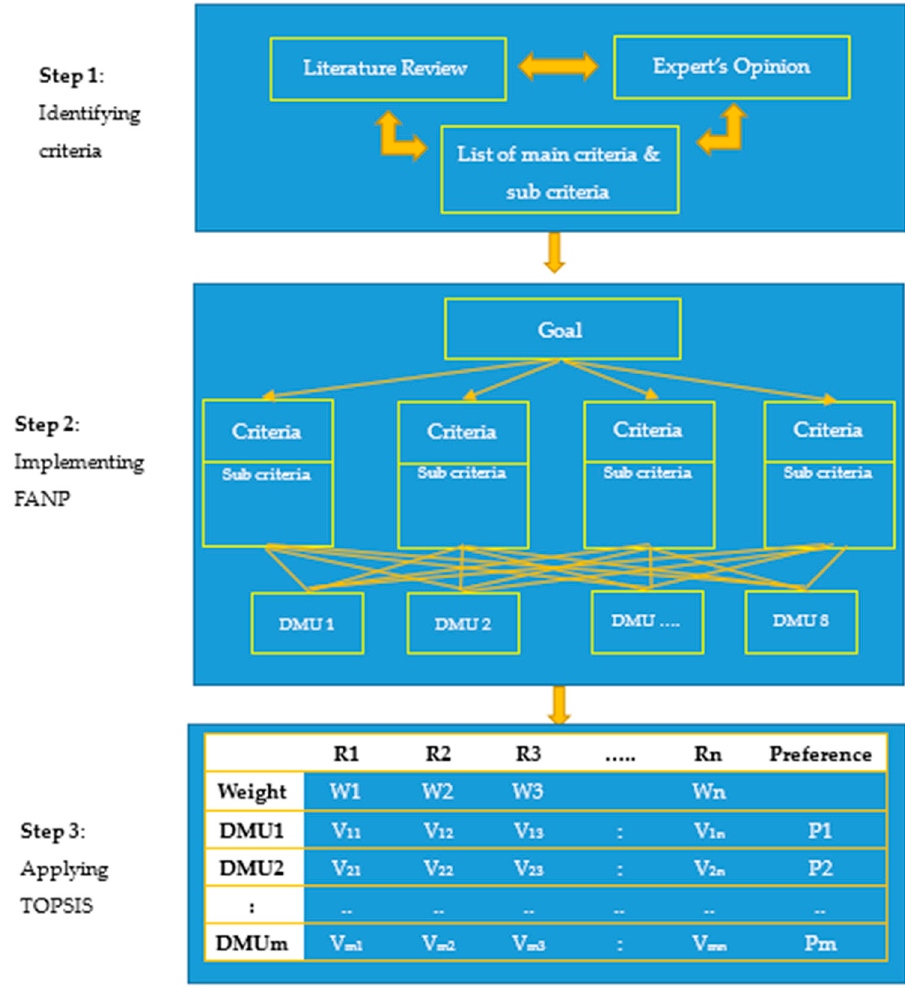
Figure 3. Research methodologies.